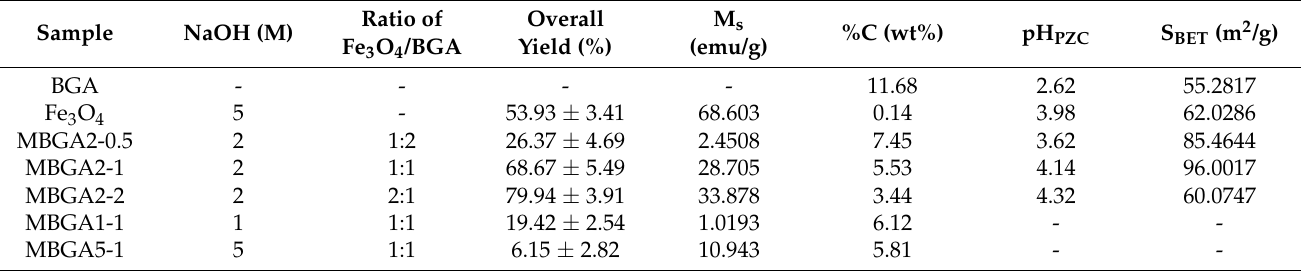
Figure 1. VSM hysteresis loops for all samples. Table 1. Optimization of the preparation conditions and their physical and chemical properties.